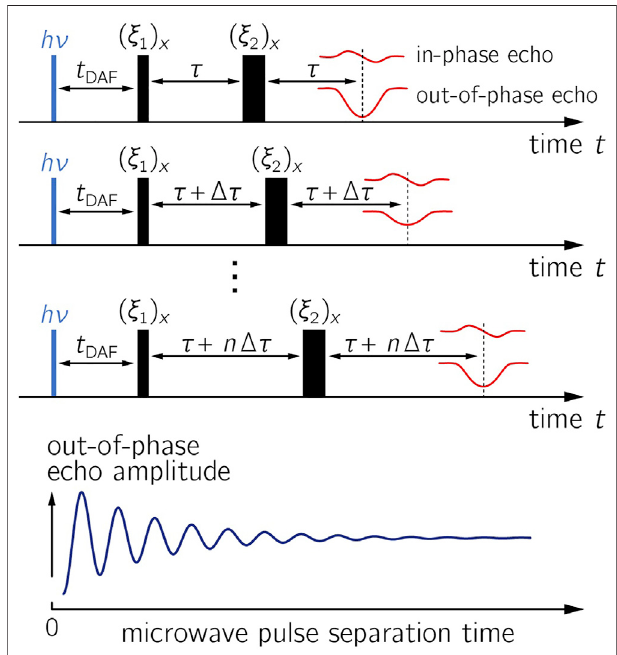
FIGURE 1 | OOP-ESEEM pulse sequence. In the upper panels, the evolution of the in-phase and out-of-phase (OOP) echo components are depicted; the resulting time trace with respect to the pulse separation time is shown in the lower panel. Parameters: t DAF , time delay after the laser fl ip angles of microwave pulses with phase x ; in-phase and out- fl ash ( h ] );( ξ i ) x , of-phase (OOP) signals denote the signals in the y - and x -channels during quadrature detection. During the experiment, the time between the microwave pulses is varied stepwise while t DAF is kept constant. The amplitude of the OOP signal is recorded as a function of the microwave pulse separation